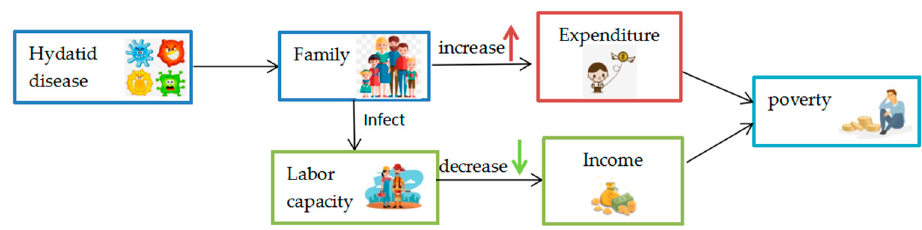
Figure 4. Relationship between the Hydatid disease and poverty.